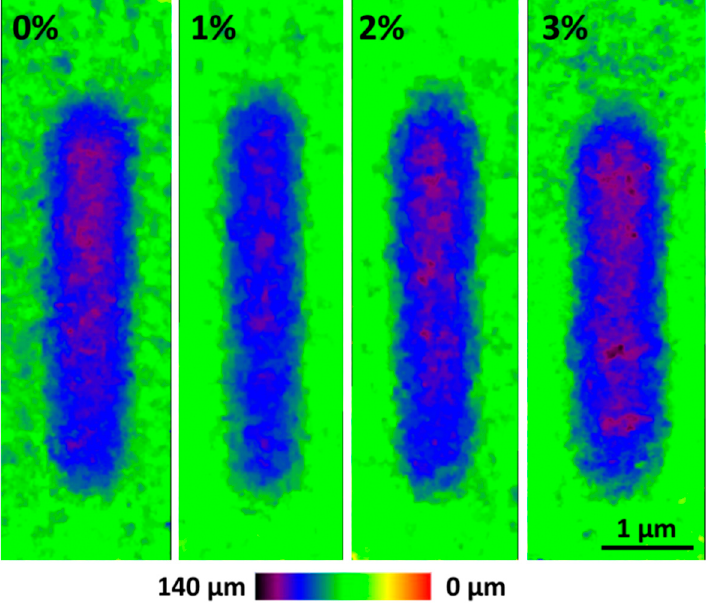
Figure 8. Wear tracks of all organic coatings after 500 h of xenon exposure.